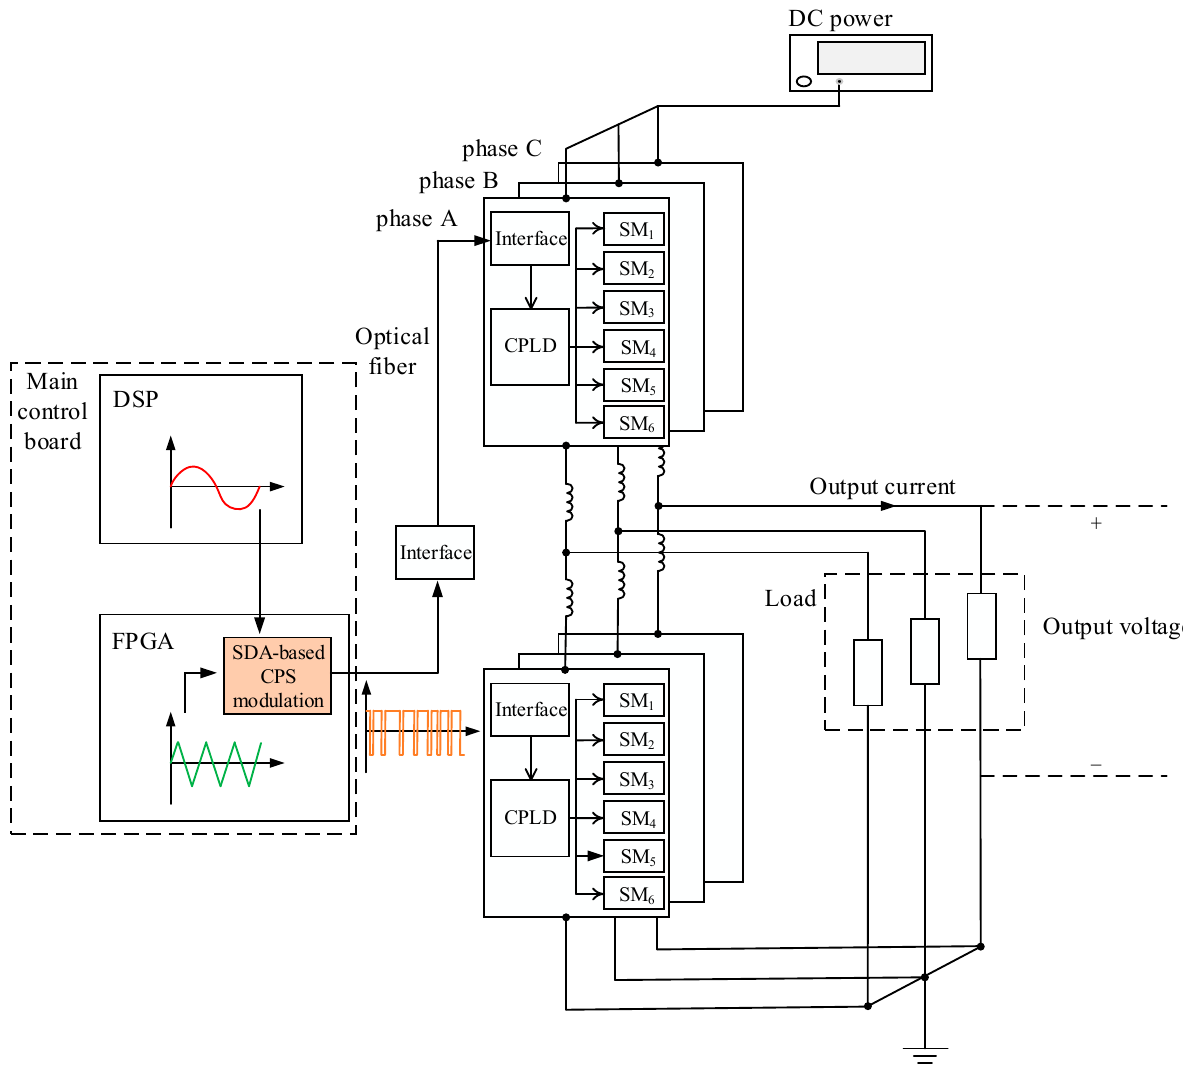
Figure 9. Main structure diagram of MMC experimental platform.